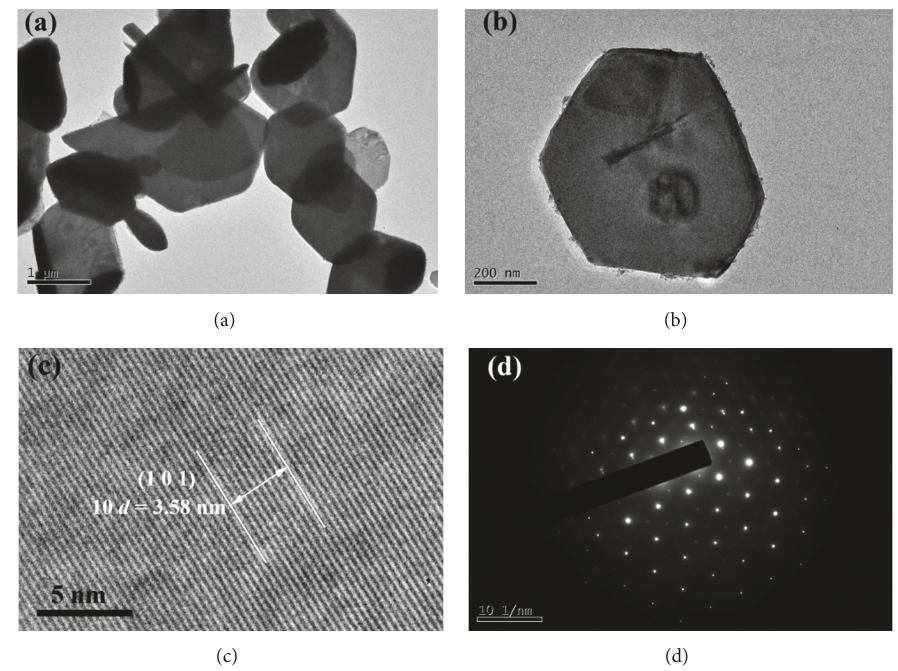
Figure 3: ((a), (b)) TEM images, (c) high-resolution TEM image, and (d) SAED pattern of Bi 2 Se 3 nanoplates.